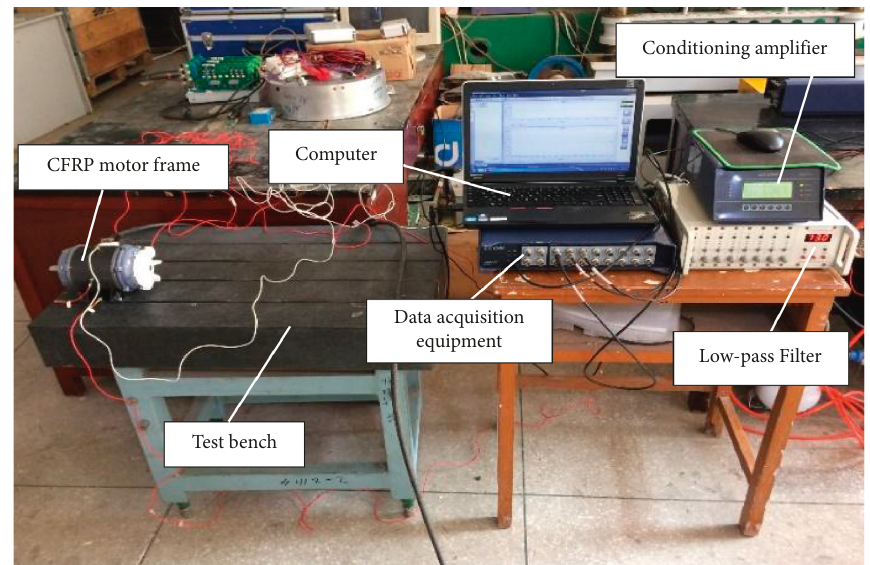
Figure 10: Vibration testing of the CFRP frame motor.